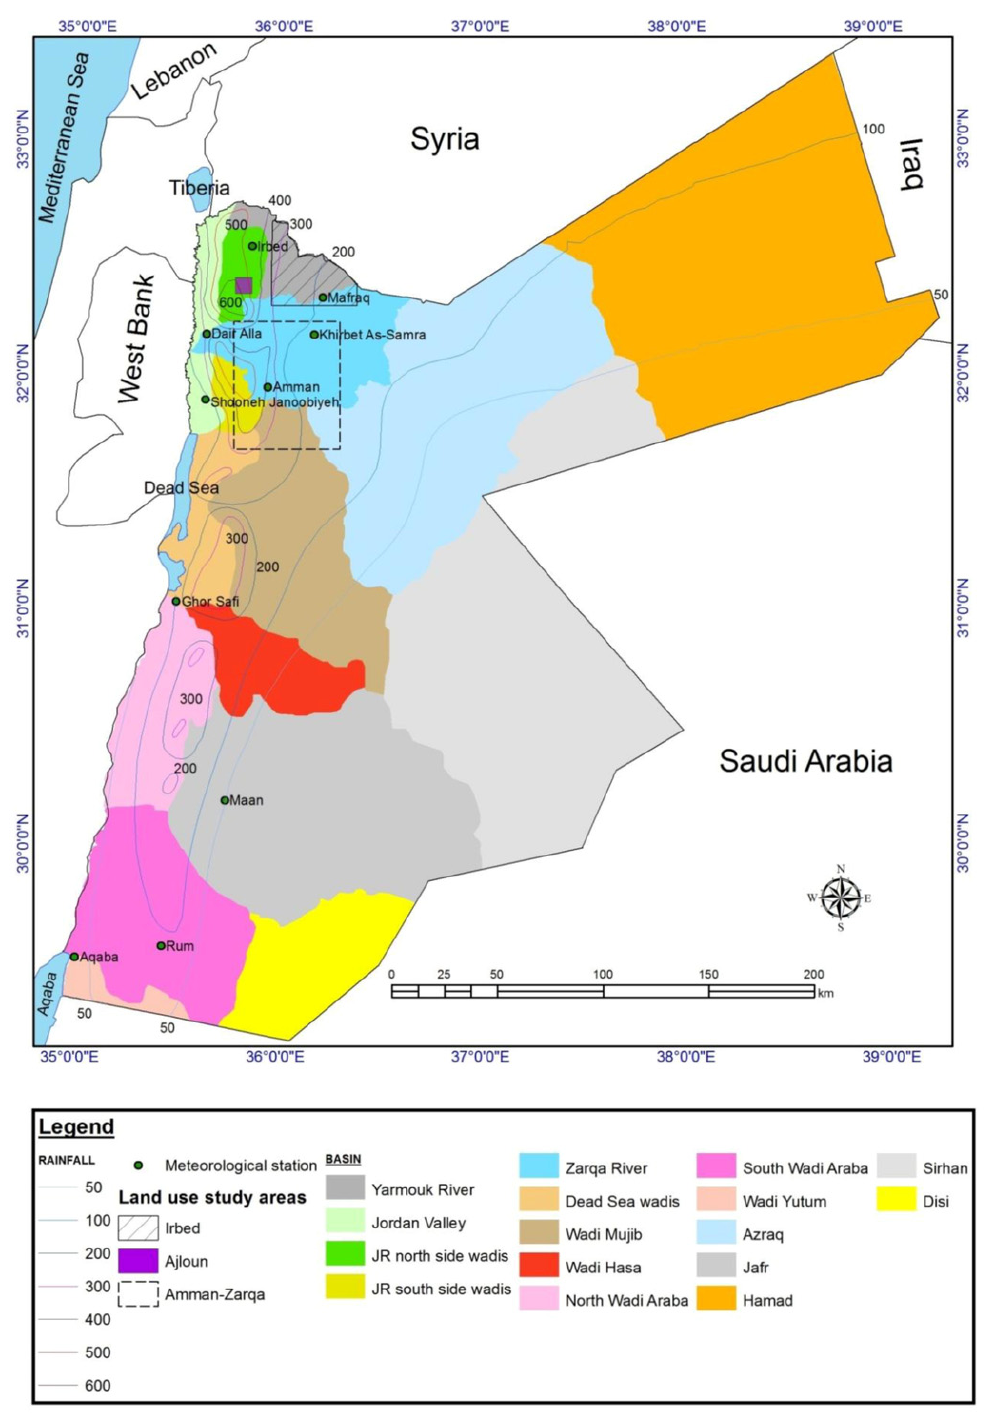
Figure 1. Map of Jordan with surface water basins and rainfall isohyets. Source: